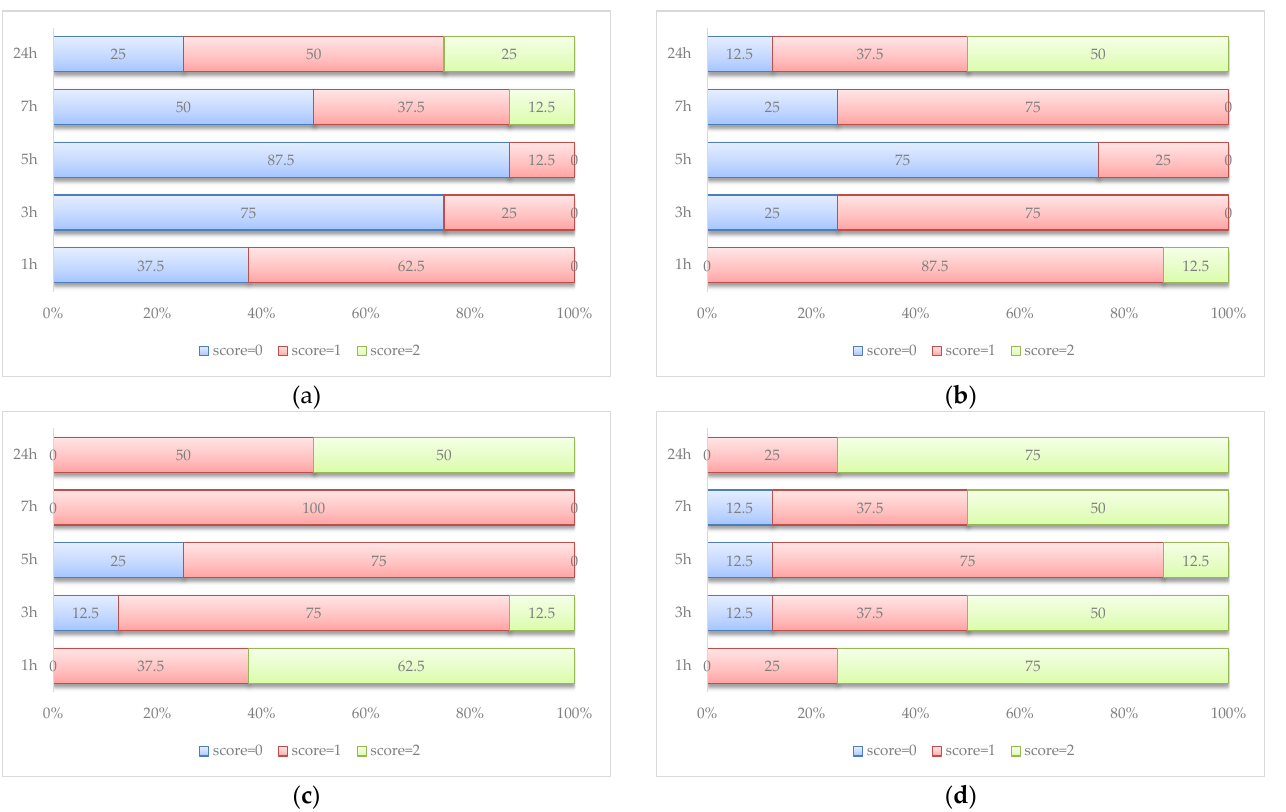
Figure 6. Percentage distribution of motility scores by group: ( a ) AI-GRCE100 group; ( b ) AI-GRCE200 group; ( c ) AI-GRCE100-D group; and ( d ) AI-GRCE200-D group. Score 0 = rat walked with difficulty and avoided touching the toes of the inflamed paw to the floor; score 1 = the rat walked with little difficulty, but it touched the floor with the toe of the inflamed paw; score 2 = rat walked easily without any difficulties.